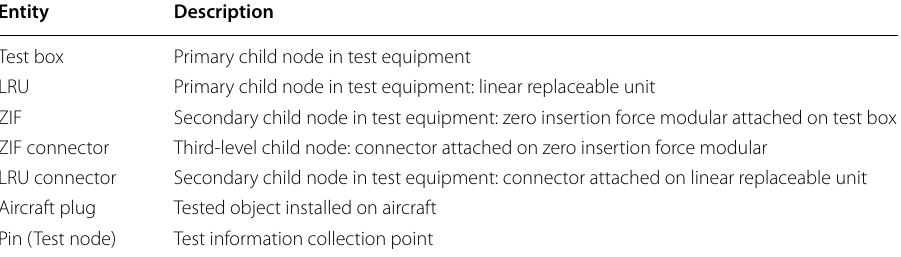
Table 1 Entities and properties of AWTE